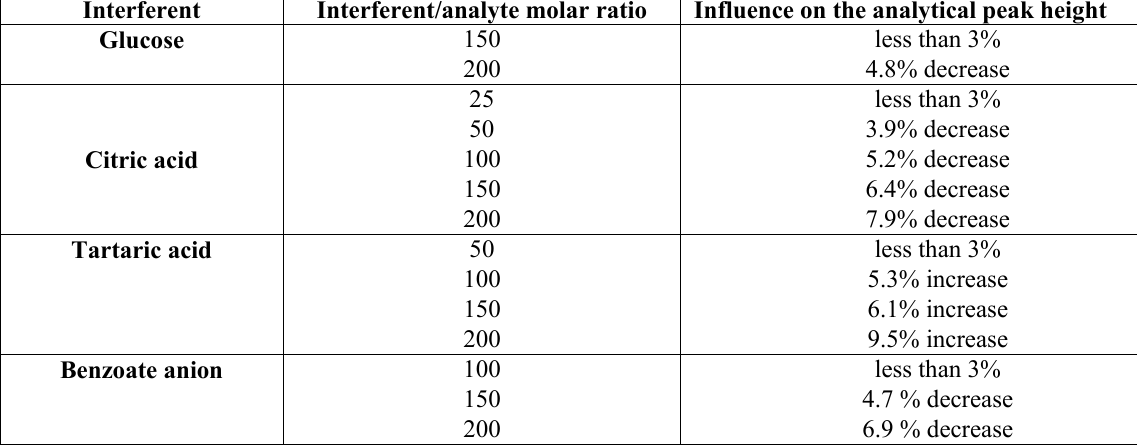
Table 1. Study of interferences at ascorbic acid determination by DPV at a Pt electrode, performed on some chemical species commonly found in fruit juices, soft drinks and wines.